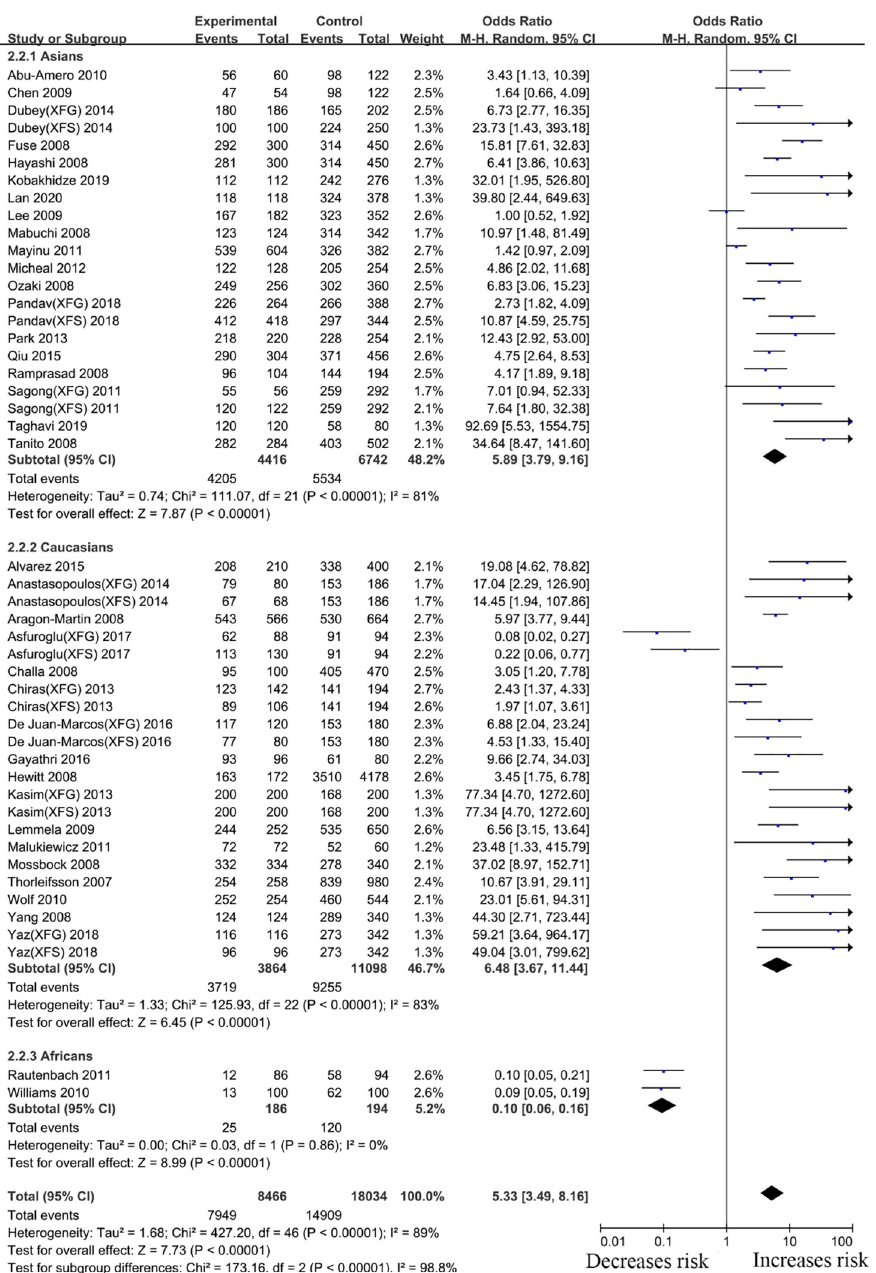
Fig 7. Meta-analysis for the association between exfoliation syndrome/exfoliation glaucoma risks and LOXL1 gene polymorphism rs3825942 (G vs. A): Subgroup analysis by ethnicity (squares depict individual studies and diamonds depict summary effect size estimates (Odds Ratio,